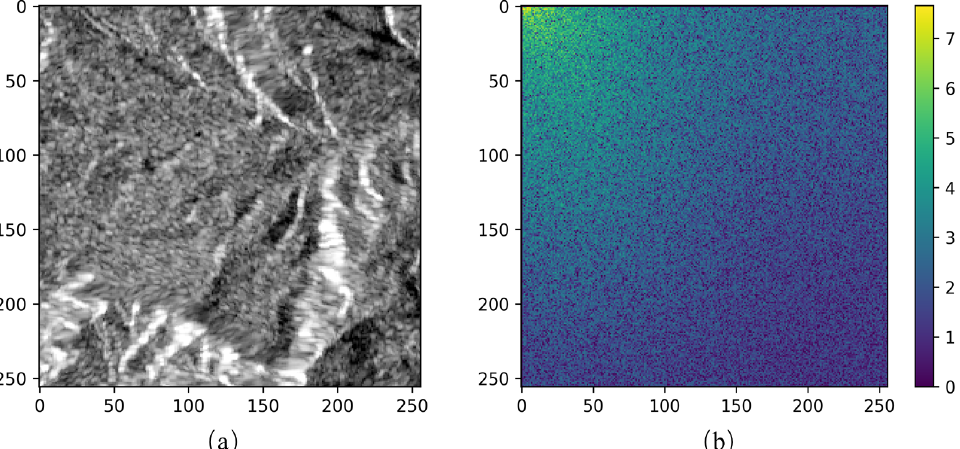
Figure 4. The characteristic of the DCT. ( a ) The SAR image, and ( b ) the corresponding DCT image. Best viewed in